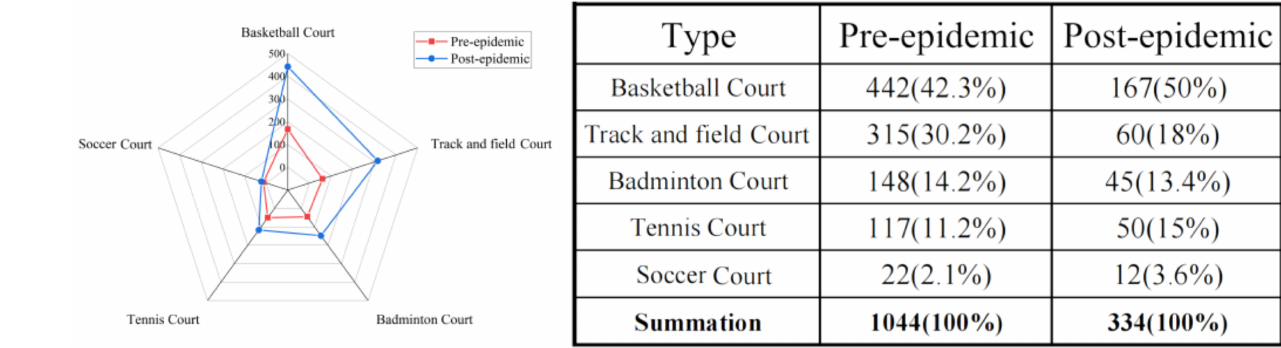
Figure 6. Changes of the structural proportion of the outdoor sports venues in